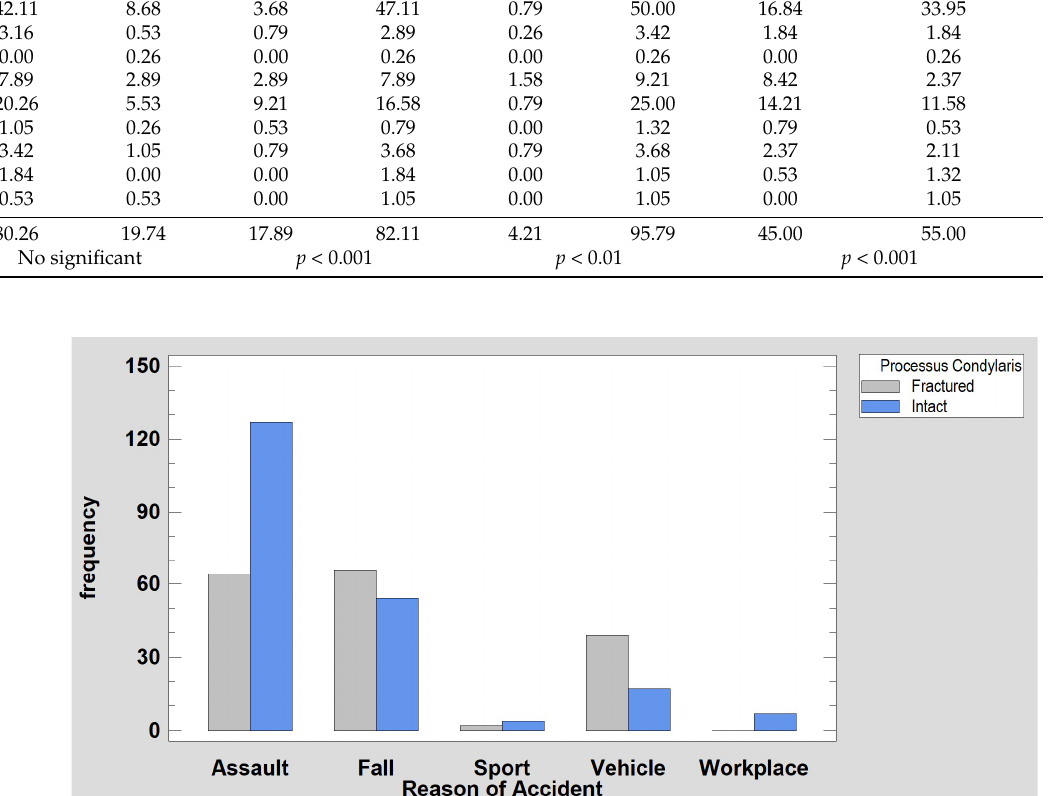
Table 1. Detailed reasons for mandibular fractures (%, χ 2 test of independence).